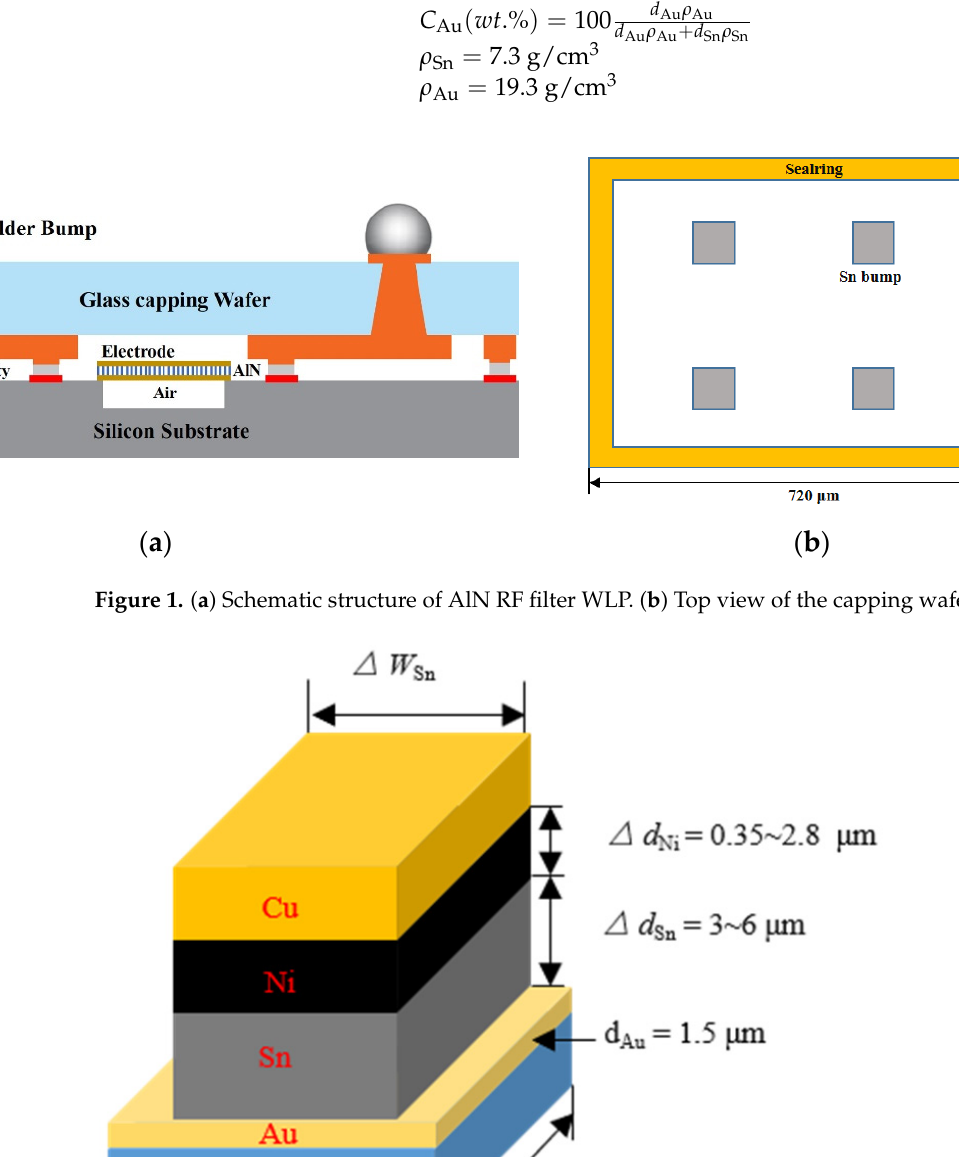
C is the effective Au concentration. d and d are the thickness of the Au Sn Au ρ and ρ are the densities of the Au and Sn, respectively. Sn and Au, respectively. Au Sn Figure 2. The simplified Au/Sn/Ni/Cu micro-joint. Figure 2. The simplified Au/Sn/Ni/Cu micro-joint. critical thickness of the Sn layer is set to 3 µ m, 5 µ m, 6 µ m. Applying Equation (1), the effective Au concentration C Au